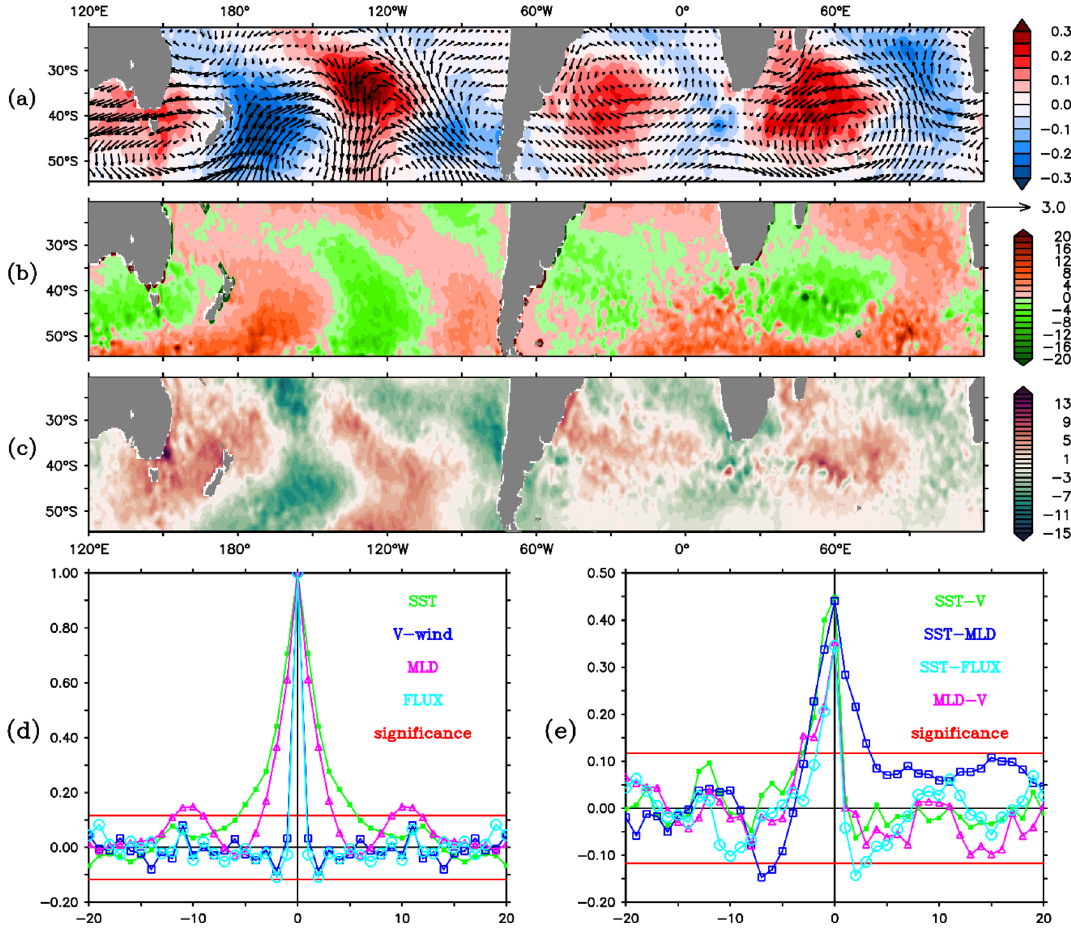
Figure 7. Second SVD mode of anomalous ( a ) SST (shaded) and wind at 850 hPa (vector), ( b ) MLD and ( c ) latent heat flux. ( d ) Auto-correlation and ( e ) cross-correlation of SST, meridional wind (V), MLD and, latent heat flux (FLUX, positive downward) in pairs as indicted by the levels. The x-axis in ( d ) and ( e ) represents the lead/lag in months and y-axis represents the correlation coefficients. Positive lag means first variable is leading the second. Solid red line shows the 99% significance